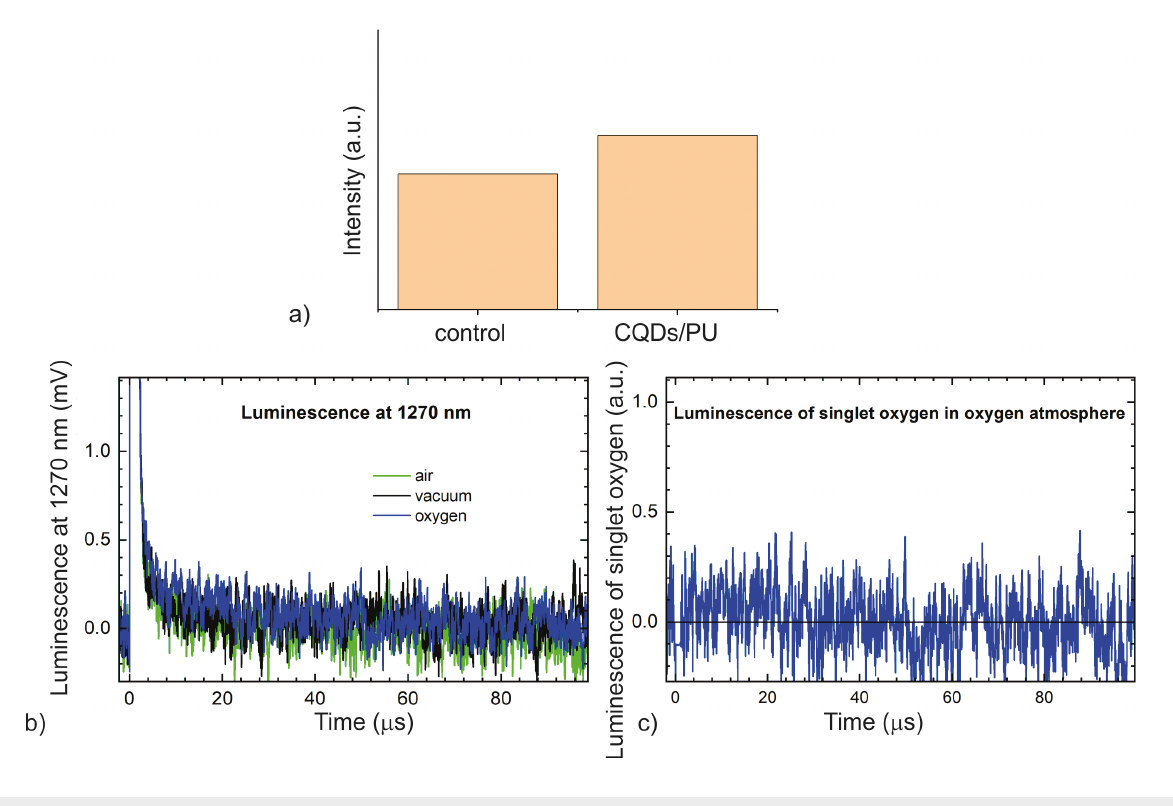
Figure 3: (a) Intensity of the EPR signal of control (left) and CQDs/PU composite sample (right); (b) luminescence of the CQDs/PU composite at 1270 nm in different atmospheres; (c) singlet oxygen luminescence of the CQDs/PU composite in oxygen atmosphere calculated as the difference be- tween traces in oxygen atmosphere and